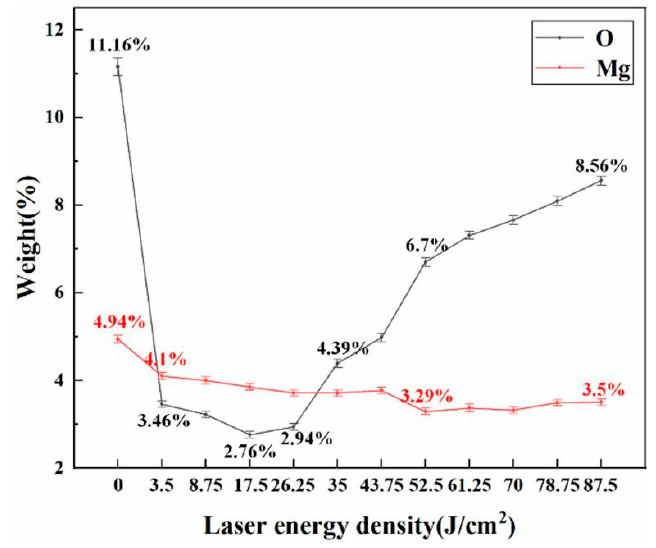
Figure 4. Changes in surface elements with different laser energy densities [33].